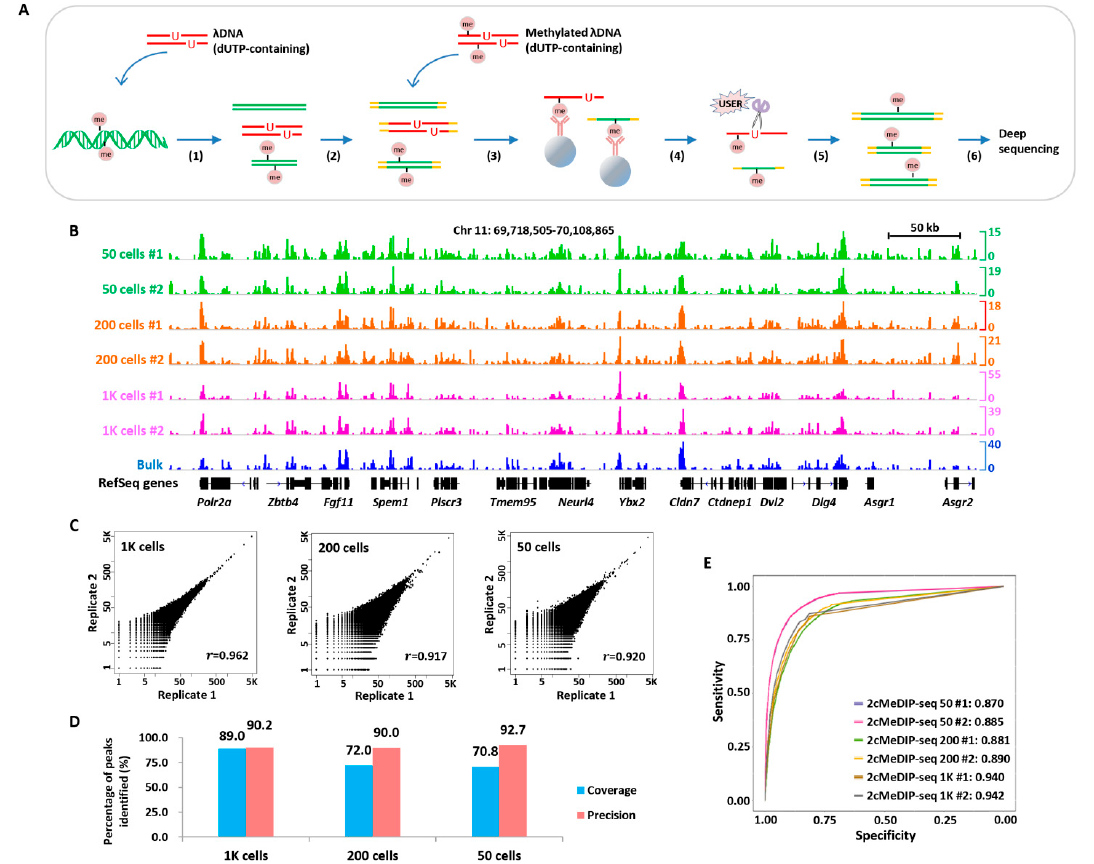
Figure 5. 2cMeDIP-seq generates high-quality DNA methylone profiles with limited numbers of cells. ( A ) Overview of 2cMeDIP-seq protocol. Following (1) sample preparation and sonication, dUTP-containing λ DNA (lambda DNA) fragments are added as carrier, (2) repair of DNA ends and ligation of barcoded adaptors, (3) immunoprecipitation with antibody, methylated λ DNA (dUTP-containing) fragments are added as carrier, (4) reverse-crosslinking, (5) elution and USER digestion, (6) PCR amplification and deep sequencing. ( B ) Normalized 2cMeDIP-seq data generated with distinct numbers of FGSCs are shown for the indicated region. The ‘bulk’ data generated with millions of cells using the MeDIP-seq protocol is shown for comparison. ( C ) Scatter plot comparison of two 2cMeDIP-seq biological replicate datasets generated with various numbers of cells. The r indicates Pearson’s correlation coefficient calculated as in Figure 2C. ( D ) Bar chart showing coverage and precision of 2cMeDIP-seq signals in the indicated numbers of cells compared with the bulk counterpart. ( E ) ROC curves for the comparison for the 2cMeDIP-seq data generated by distinct numbers of cells. Values shown are AUC. Chr, chromosome. #1 and #2, two biological